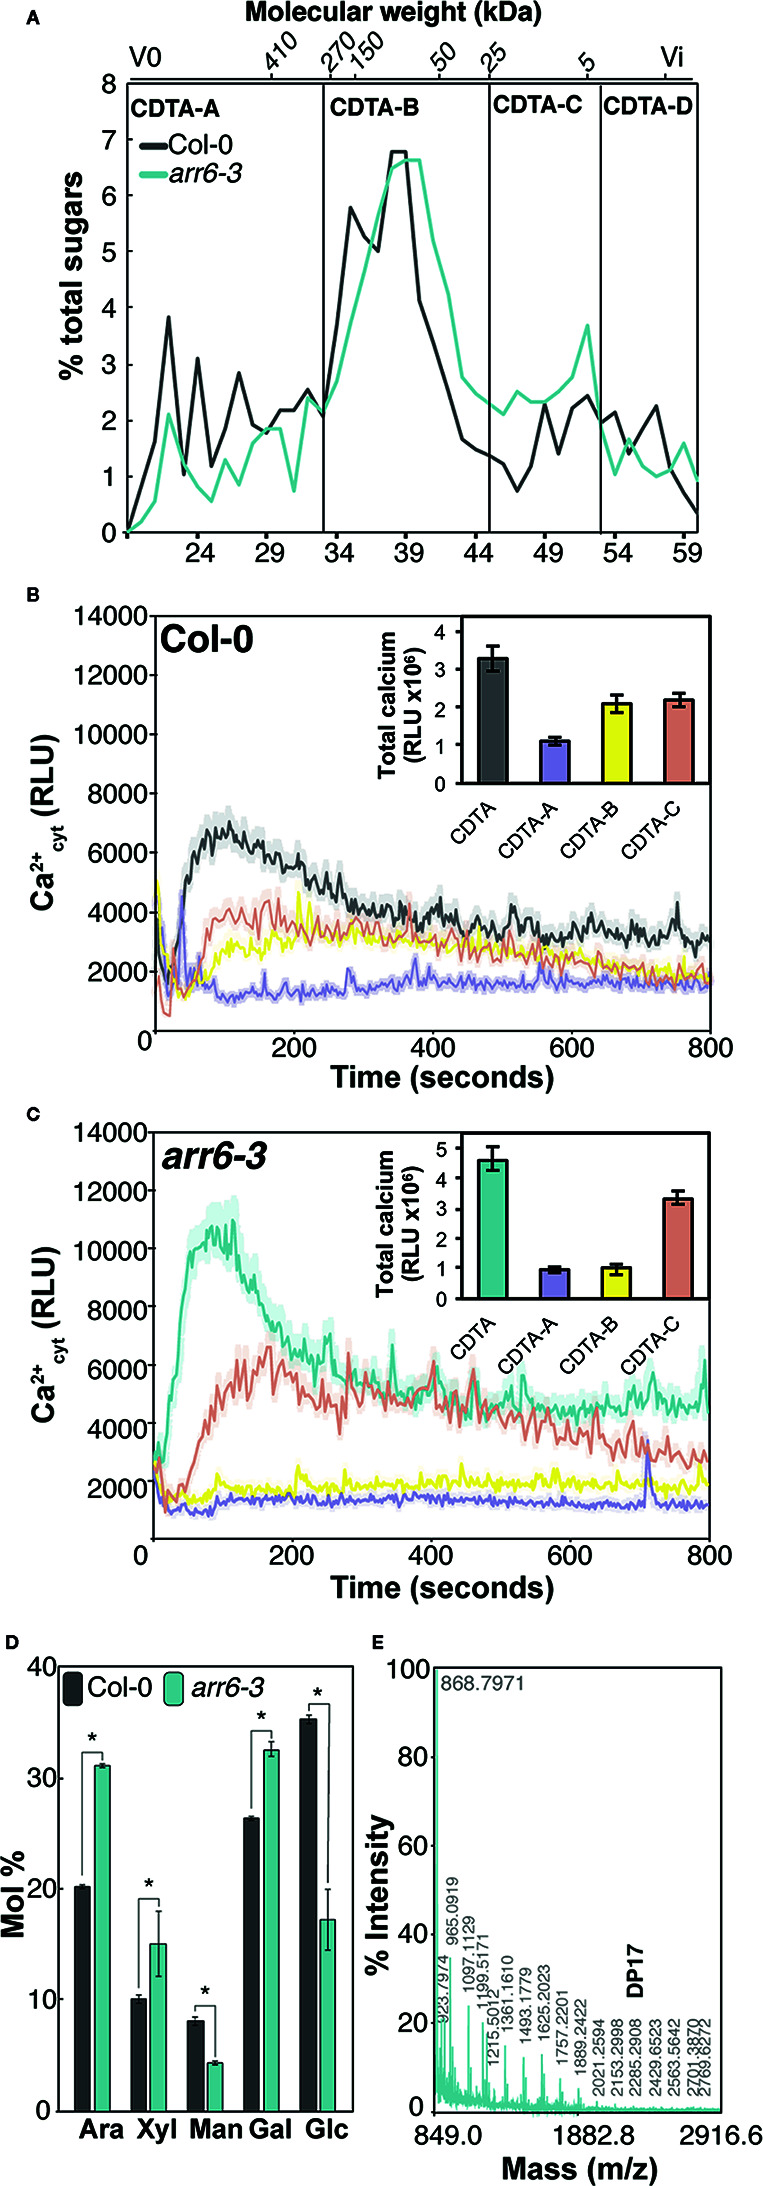
Pectin-CDTA sub-fractions between 25 and 5 kDa retain most of the activity triggering Ca2+ influxes and are enriched in pentose oligosaccharides. (A) Size exclusion chromatography (SEC) elution profile (Sepharose CL-6B) of pectin fractions (CDTA extract) from wild type (Col-0) and arr6-3 plants. The Sepharose column was calibrated with commercial dextrans of known weight-average relative molecular mass and the elution fraction number (bottom) of some of them is indicated on the top of the chromatogram. The elution profiles were monitored by total sugar quantification (phenol-sulfuric method). Sub-fractions were defined as: [A] > 270 kDa, [B] 270–25 kDa, [C] 25–5 kDa, [D] <5 kDa. Profiles are representative of ten independent preparations. (B, C) Ca2+ influx kinetics triggered by CDTA sub-fractions A-C from Col-0 (B) and arr6-3
(C) plants in Col-0AEQ seedlings. Elevations of cytoplasmic calcium concentrations over 800 s were measured as relative luminescence units (RLU). Data are means (n=8) from one experiment representative of three independent ones with similar results. The total areas-under-the-curves were integrated and their average values ± SD (n=8) are represented at the right side of each panel. (D) Monosaccharide composition (Mol % ± SD, n=3) of Col-0, and arr6-3 CDTA-C sub-fraction. Ara: arabinose; Xyl: xylose; Man: mannose; Gal: galactose; Glc: glucose. Statistically significant differences between genotypes according to Student’s t-test (*p < 0.05). (E) MALDI-TOF mass spectrum of CDTA-C sub-fraction. M/z shifts are coherent with the presence of pentose oligosaccharides of different degree of polymerization (DP). The spectrum shown (arr6-3) is representative of all analyzed pectin I-C sub-fractions (n≥10).